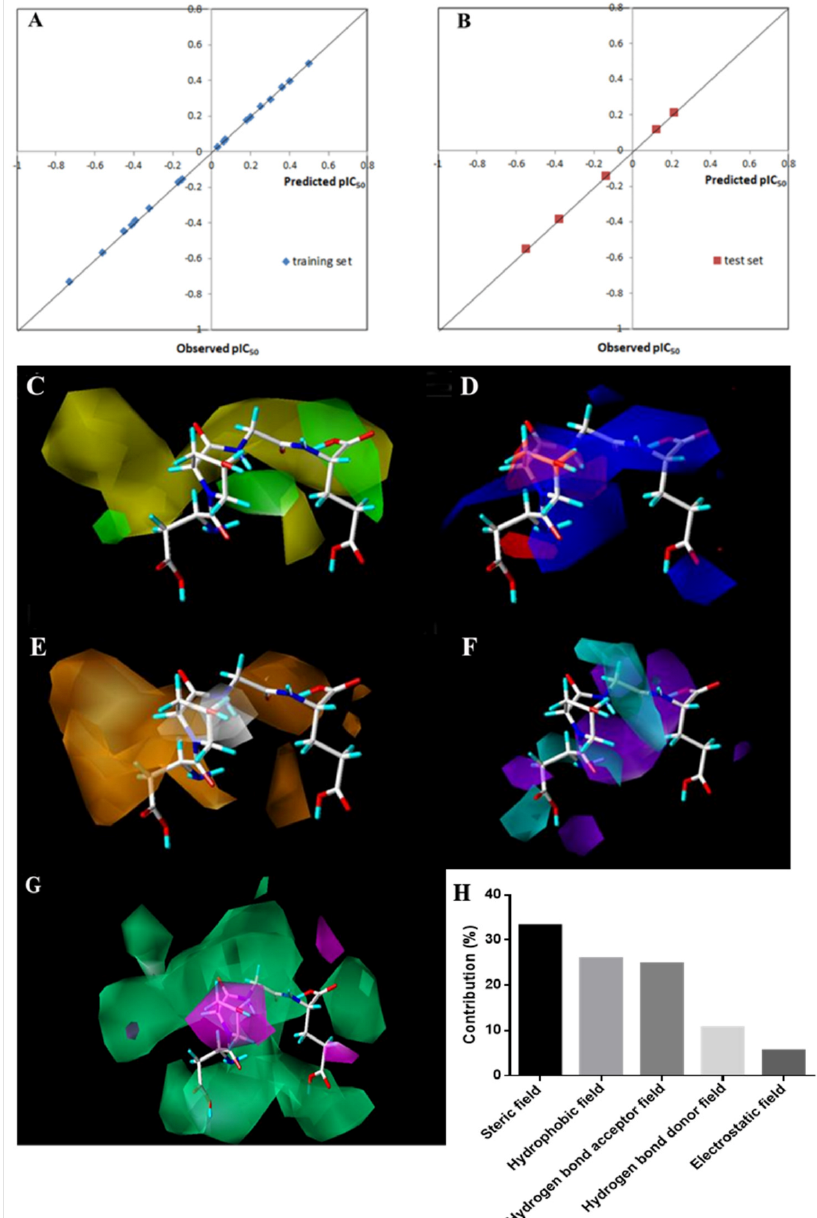
Figure 3. The 3D-QSAR model established by CoMSIA. ( A , B ) Plots of predicted values of pIC50 versus actual values for training set (r 2 = 0.999) and test set (r 2 = 0.999) of antiplatelet peptides using the CoMSIA model. ( C – G ) 3D contour plots of the peptide ROGE of the QSAR model using CoMSIA analysis. ( C ) Steric field; (D) electrostatic field; ( E ) hydrophobic field; ( F ) hydrogen bond donor field; ( G ) hydrogen bond acceptor field. ( H ) Total Contribution of different